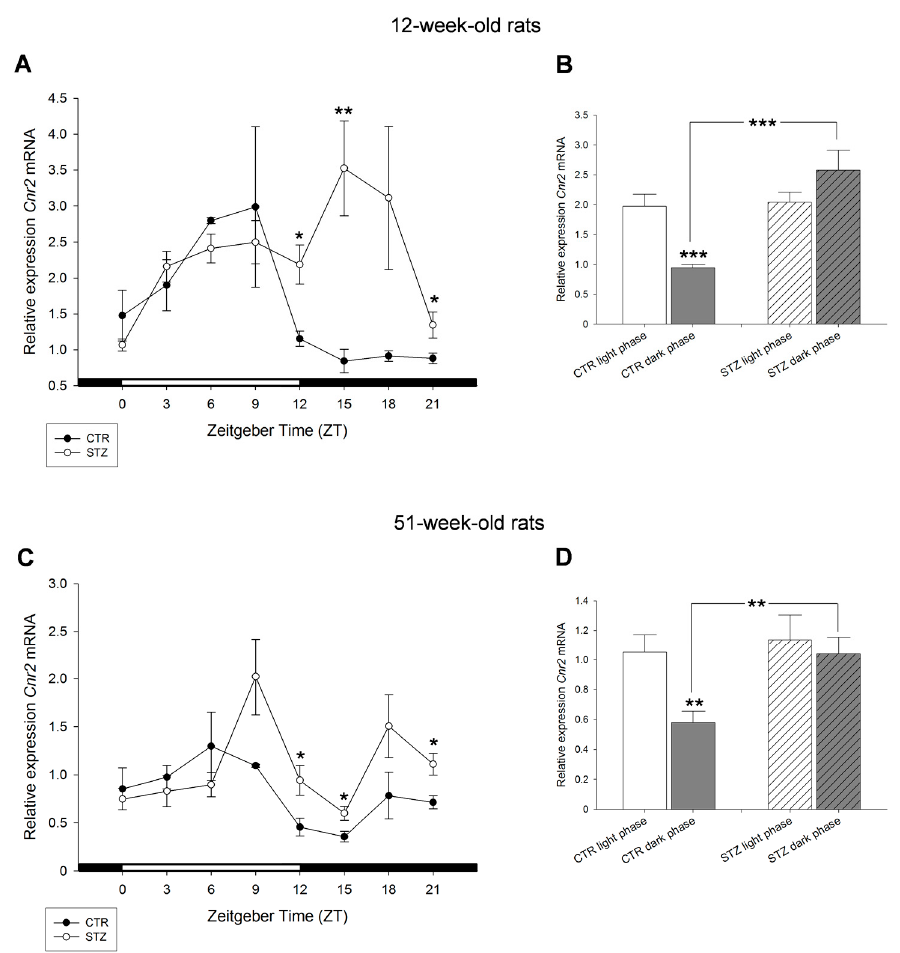
Figure 7. Effects of streptozotocin on the diurnal expression of cannabinoid receptor Cnr2 mRNA in the liver of: 12-week-old rats ( A , B ); and 51-week-old rats ( C , D ). ( A , C ) Streptozotocin treated Wistar rats (STZ) compared to control Wistar rats (CTR). ( B , D ) Values of light phase as well as those of dark phase are summarized for Cnr2 mRNA of control Wistar rats (CTR) and streptozotocin treated rats (STZ) showing increased expression of Cnr2 mRNA in STZ rats during dark period compared to control. Values are means ( ± S.E.M.), as analyzed by Mann–Whitney test. * p < 0.05, ** p < 0.01, *** p < 0.001.